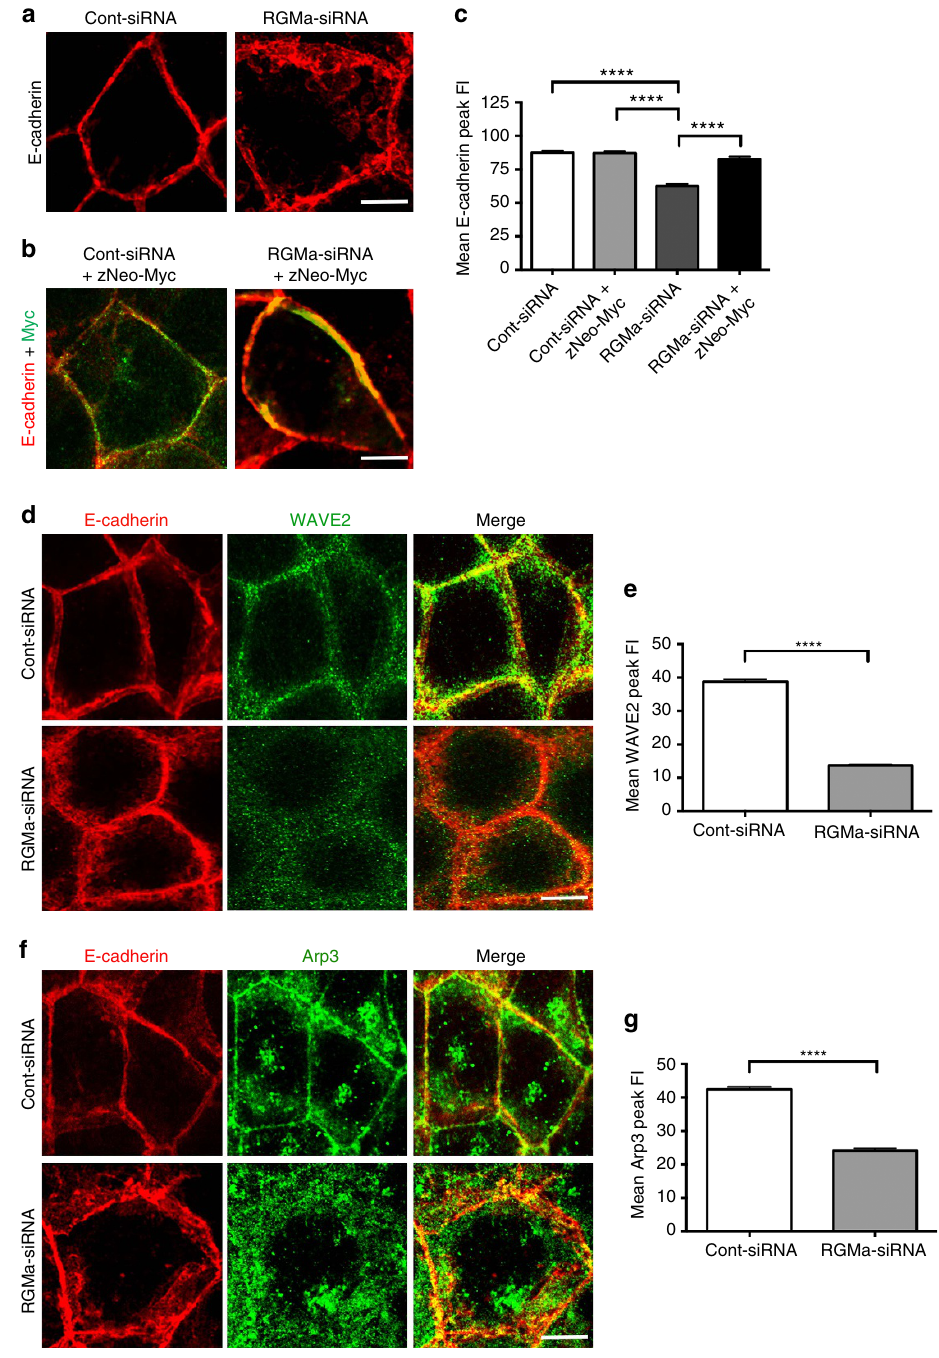
Figure 7 | RGMa is required for AJ stability and recruitment of the WRC and Arp2/3. ( a ) RGMa-siRNA induced the loss of junctional integrity (Ecad þ , red). ( b ) Coexpression of zNeo-Myc (green; Ecad, red; merge, yellow) with RGMa-siRNA rescued junctional integrity. ( c ) Line-scan analysis: mean Ecad peak fluorescence intensity (FI) in cells coexpressing RGMa-siRNA and zNeo-Myc or RGMa-siRNA alone ( n ¼ 150 junctions, mean ± s.e.m., **** P o 0.0001, one-way analysis of variance (ANOVA), Dunn’s post hoc test). ( d ) WAVE2 (green) was not associated with Ecad (red) at the AJ in RGMa-siRNA- expressing cells. ( e ) Line-scan analysis: mean WAVE2 peak FI in RGMa-siRNA cells. ( f ) Arp3 (green) was not associated with Ecad (red) at the AJ in RGMa-siRNA-expressing cells. ( g ) Line-scan analysis: mean Arp3 peak FI in RGMa-siRNA cells. ( e , g ) n ¼ 150 junctions, mean s.e.m., **** P o 0.0001, Student’s t -test. Scale bars, 15 m m ( a , b , d , f